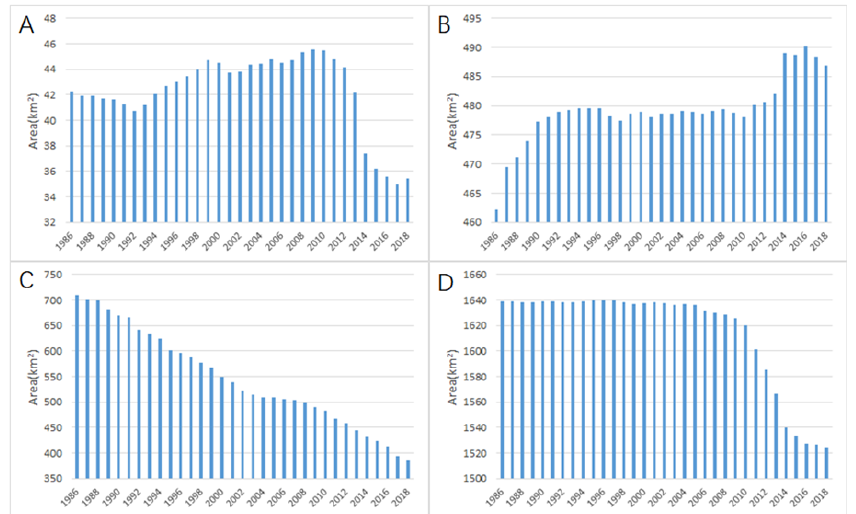
Figure 6. The change of coastal wetlands area in the LRE from 1986 to 2018. ( A ) seepweed, ( B ) reeds, ( C ) tidal flats, ( D ) shallow marine water.